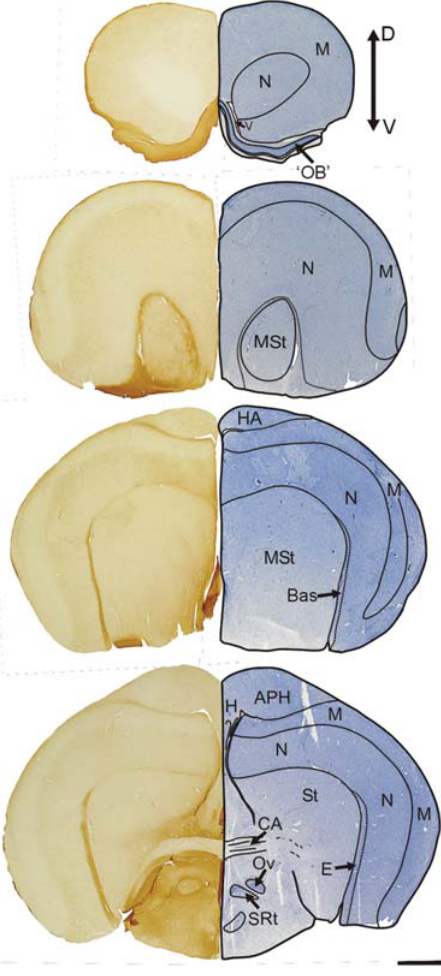
Figure 4. Organisation of the forebrain of the Kiwi. Series of coronal sections through the forebrain of the Kiwi (top rostral, bottom caudal). Left hemisections show the regional demarcation that results from CR- LI. APH: Parahippocampal area; Bas: Nucleus basorostralis; CA: Anterior commissure; E: Entopallium; HA: Hyperpallium apicale; M: Mesopallium; MSt; Medial Striatum; N: Nidopallium; OB: olfactory ‘bulb’; St: Striatum; H: Hippocampus; Ov: Nucleus ovoidalis; SRt: Nucleus subrotundus; v: ventricle. Scale bar: 2 mm.